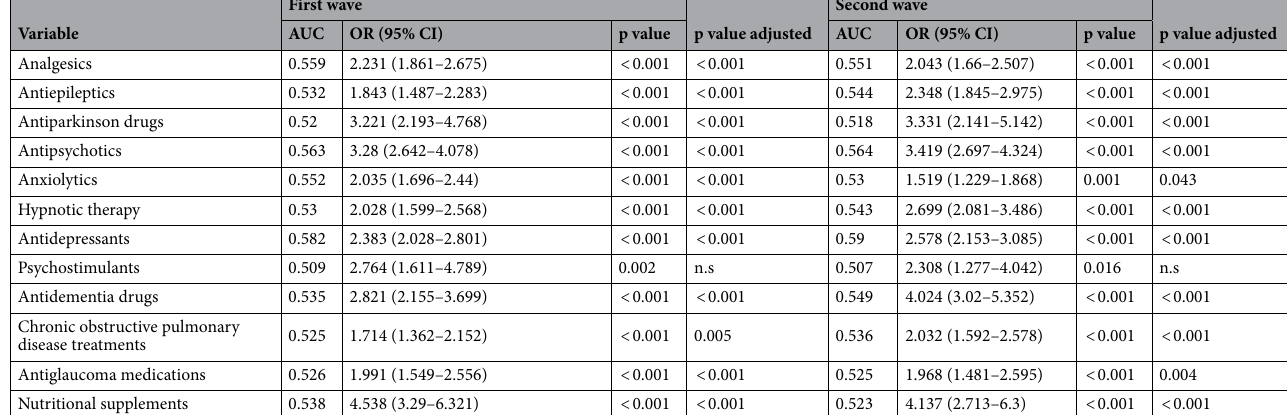
Table 2. Univariate analysis of potential predictors of death in the two pandemic waves, Aragon, Spain, February–September, 2020. OR: Odds ratio; CI: confidence interval; n.s.: Not Significant. P value adjusted: adjusted p-values for multiple comparisons using the Holm method.